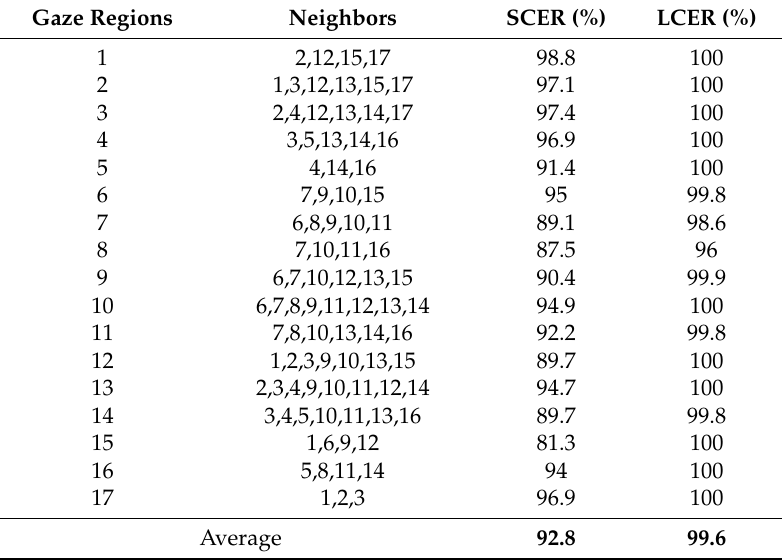
Table 7. SCER and LCER of scheme 1 without PCCR vectors.